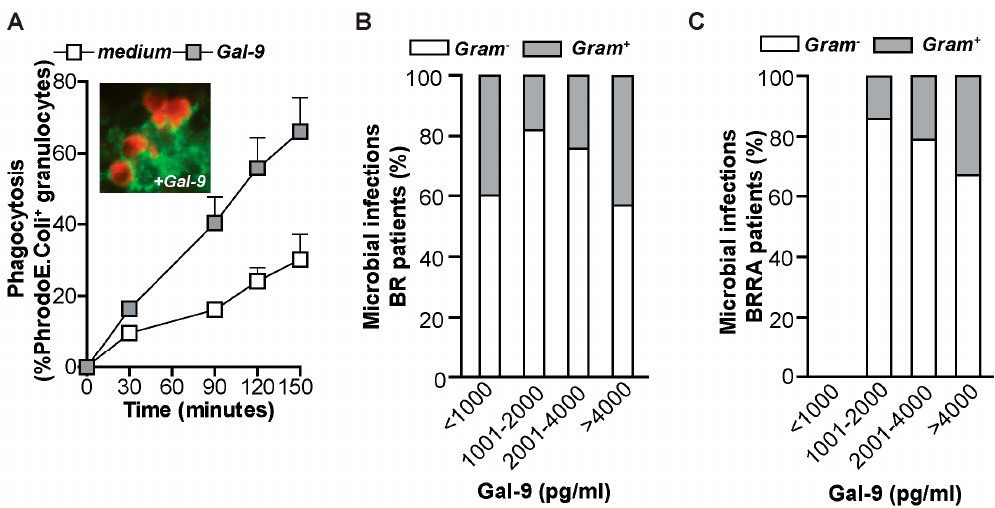
Figure 5. Gal-9 induces phagocytosis ( A ) Phagocytic uptake of PHrodo E. coli by granulocytes after pre-activation with Gal-9 (16 h, 10 nM). Inset: Fluorescent picture of phagocytosed E. coli (red) in granulocytes pre-treated with Gal-9 and stained for CD11b. 40 × magnification. ( B ) Percentage of Gram-negative and Gram-positive lung infections occurring in BR and ( C ) BRRA patients with different Gal-9 serum levels.